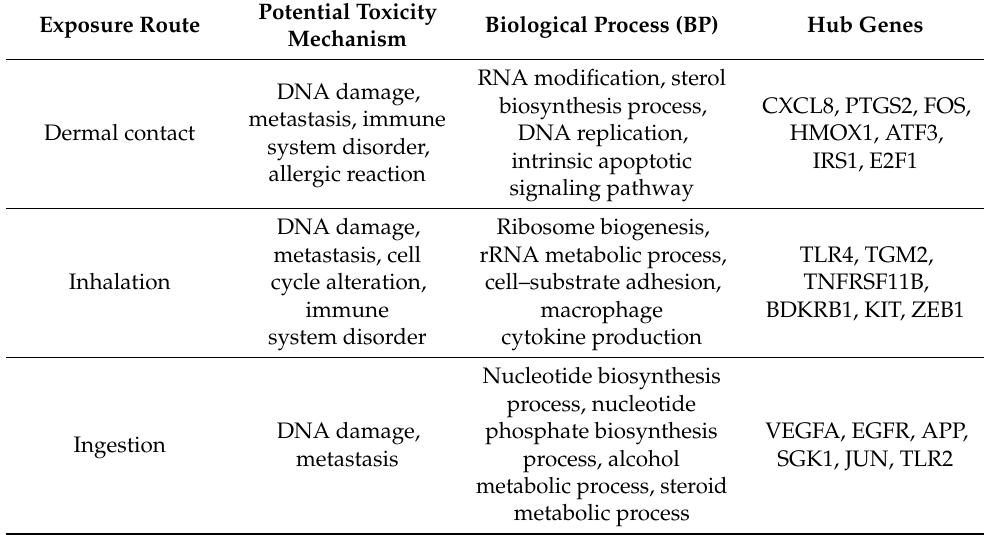
Table 1. Potential toxicity mechanism, biological processes, and hub genes of Cr exposure dependent on different exposure